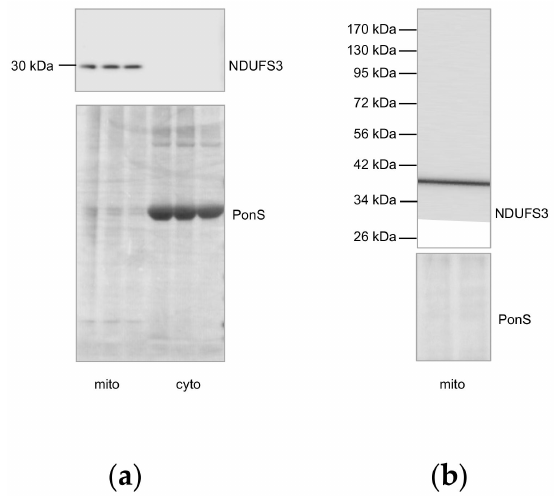
Figure A3. Cytoplasm-suspended mitochondria were incubated for 30 min with 10 mM dopamine (DA) at 37 ◦ C. Mitochondrial and cytoplasmic fractions were subjected to SDS-PAGE under nonre- ducing conditions. Membranes were probed with anti-NDUFS3 antibody. ( a ) Lack of NDUFS3 immunoreactivity in cytoplasmic fraction. ( b ) Lack of NDFS3 immunoreactivity above 30 kDa. Abbreviations: cyto, cytoplasm; mito, mitochondria; PonS, Ponceau S (loading